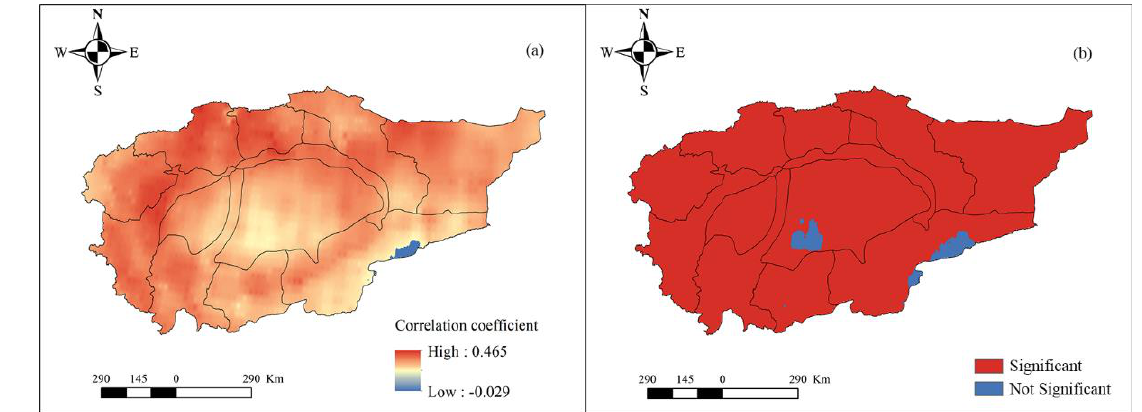
Figure 7. The correlation between SPI and SWSI on a monthly scale ( a ) and its significance ( b ).